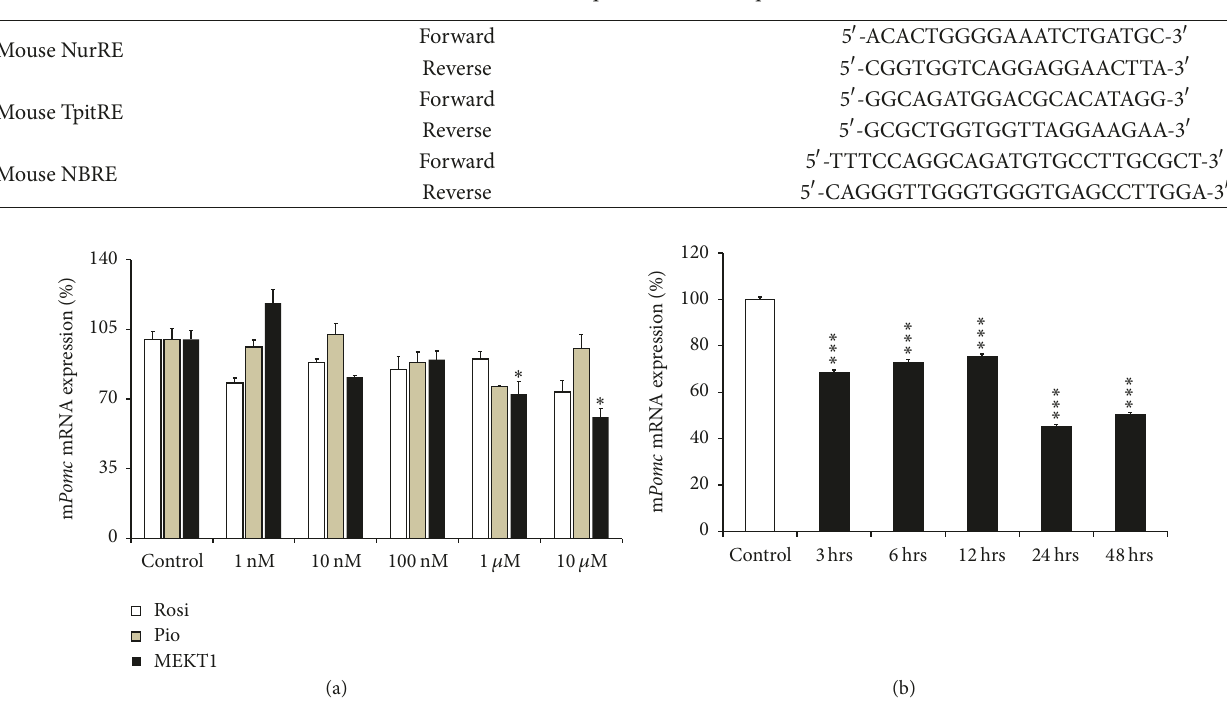
Figure 1: Effects of MEKT1, rosiglitazone, and pioglitazone on mRNA expression of Pomc in AtT20 cells. (a) Effects of MEKT1, rosiglitazone, and pioglitazone on mRNA expression of Pomc dose-dependently. AtT20 cells were treated with MEKT1, rosiglitazone (Rosi), and pioglitazone (Pio) (1nM, 10 nM, 100nM, 1 𝜇 M, or 10 𝜇 M) or 0.1% DMSO (vehicle control) for 24 hours. ∗ 𝑃 < 0.05 versus control. (b) Effect of MEKT1 on Pomc mRNA expression time dependently. AtT20 cells were treated with 10 𝜇 M MEKT1 for 1 hour, 3 hours, 6 hours, 12 hours, or 24 hours. Vehicle control, 0.1% DMSO. Data are expressed as percentages (100%) of control. Each point indicates mean ± SEM ( 𝑛 = 4 ). ∗∗∗ 𝑃 < 0.001 versus